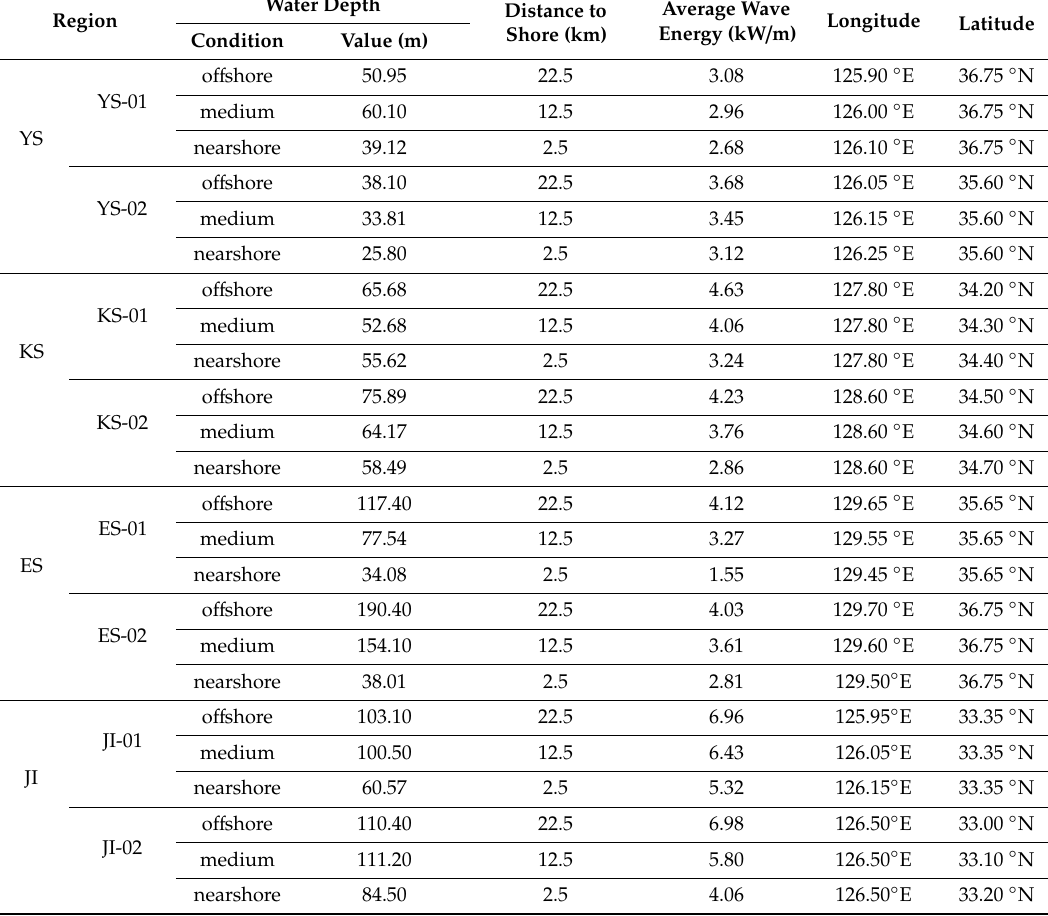
Table 8. Averaged wave energy over 12 years from 2007 to 2018 at two selected locations for each region. Nearshore, medium, and o ff shore denote the distances of locations from the shore, i.e., 2.5, 12.5, and 22.5 km,